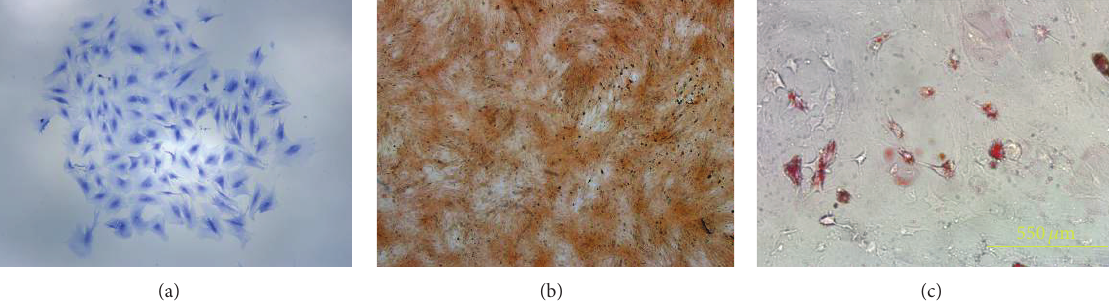
Figure 4: (a) A single colony stained with 0.1% toluidine blue ( × 100). (b) Mineralization assay: Alizarin Red S ( × 100). (c) Differentiation of PDLSCs into adipocytes ( × 100).